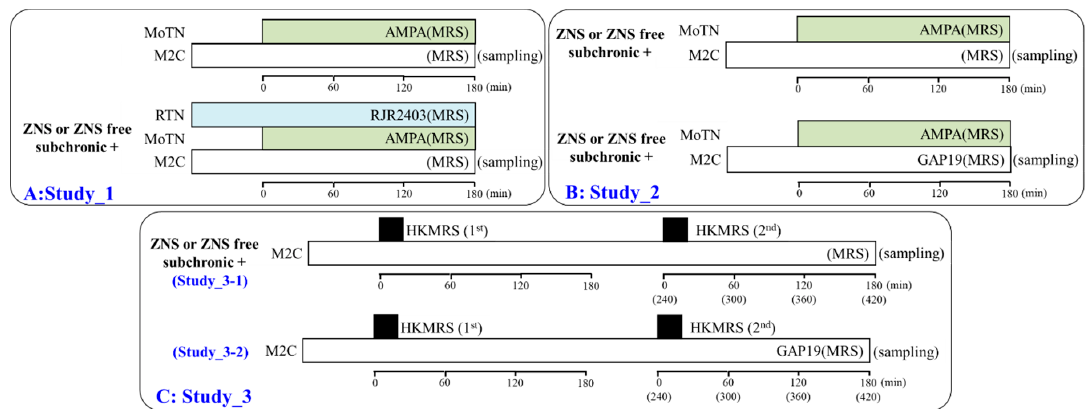
Figure 1. Schematic experimental designs of microdialysis experiments. Panels A , B , C are represented the experimental designs of Study_1, Study_2 and Study_3, respectively. MRS: modified Ringer’s solution, HKMRS: 100 mM potassium containing MRS, RJR2403 (100 μ M: selective α 4 β 2-nAChR agonist): (E)-N-Methyl-4-(3-pyridinyl)-3-buten-1-amine oxalate, AMPA (100 μ M: AMPA/glutamate receptor agonist): amino-3-(3-hydroxy-5-methyl-isoxazol-4-yl)propanoic acid, GAP19 (100 μ M: selective connexin43 (Cx43) hemichannel blocker), MoTN: motor thalamic nuclei, RTN: reticular thalamic nucleus, M2C: secondary motor cortex.